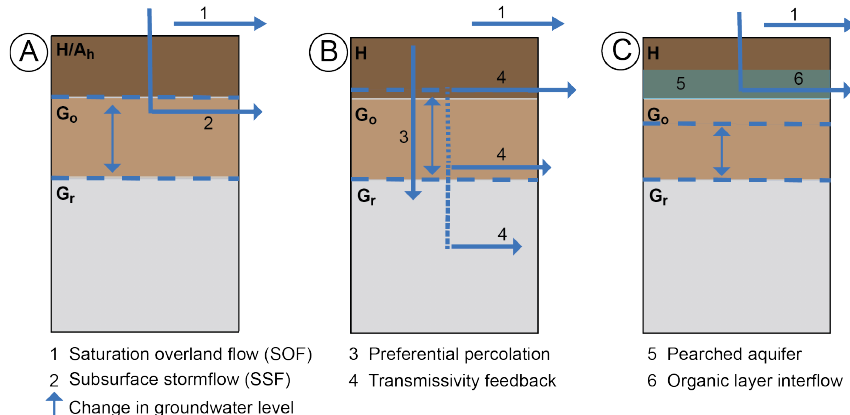
Fig. 8 Conceptual models for different types of subsurface stormflow (SSF) at the Rufiberg hillslope and the hydrology of soil types framework (HOST, after Boorman et al., 1995). SSF (2) is the dominant process, SOF (1) may occur at high precipitation rates. (A) HOST runoff response model F (gleysols): the groundwater level is rarely present in the Go horizon, thus SSF can occur in the Go horizon (e.g., soil pipes or soil matrix). (B) Conceptual model transmissivity feedback (4): preferential percolation (3) leads to a quick groundwater rise into more conductive soil layers. Depending on lateral permeability of the soil horizons, SSF evolves with the rising groundwater, generating runoff first in the Gr horizon, followed by Go and H horizons. (C) Conceptual model perched aquifer/organic layer interflow : rainfall quickly infiltrates, resulting in a perched aquifer (5) in the H horizon, which lateral discharges as saturated organic layer interflow (6). The Go/Gr horizons act as percolation barriers, which are not drained laterally.